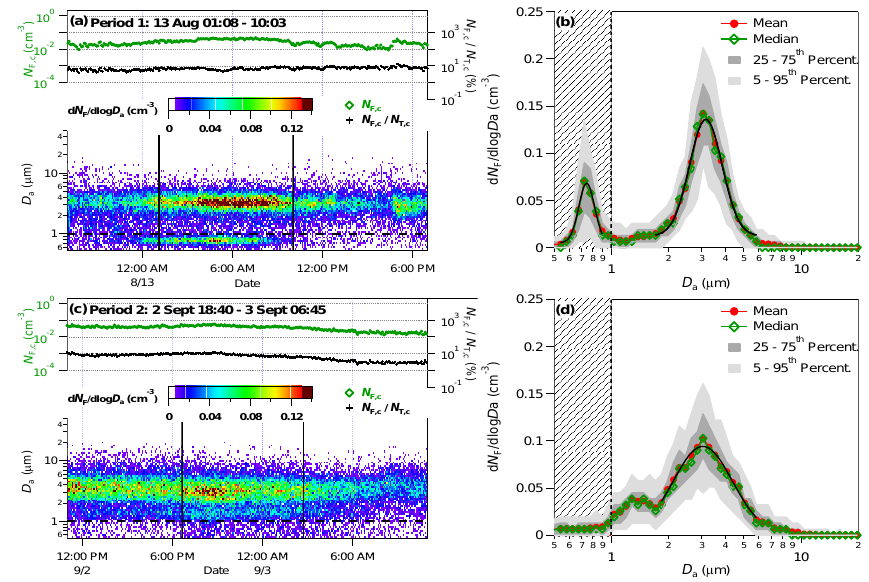
Fig. 7. Characteristic FBAP number size distribution patterns observed during exemplary periods #1 and #2. Left panels show time series of N F , c , N F , c / N T , c ratio and d N F /dlog D on days of interest (analogous to Fig. 1), and black vertical lines indicate time periods over which exemplary size distributions were averaged (d N F /dlog D a vs. D a , right panels). Red traces represent mean values, green traces represent median values, dark gray regions show 25–75th percentile range, and light gray regions show 5–95th percentile range. Hatched area below 1.0µm indicates particle size range where fluorescent particles were not considered FBAP due to interference with non-biological aerosol. Black traces are lognormal fits to individual peaks (mean values) with the following fit parameters: (a)–(b) Period #1; Fit 1.1: D a =0.54–0.90µm, D a , g =0.74µm, σ g =1.10, N =6.5 × 10 − 3 cm − 3 ; Fit 1.2: D a =1.7–5.8 µm; D a , g =3.2µm, σ g =1.22, N =2.7 × 10 − 2 cm − 3 ; (c)–(d) Period #2; Fit 2.1: D a =1.8–5.8µm; D a , g =3.0µm, σ g =1.43, N =3.7 × 10 − 2 cm − 3 .